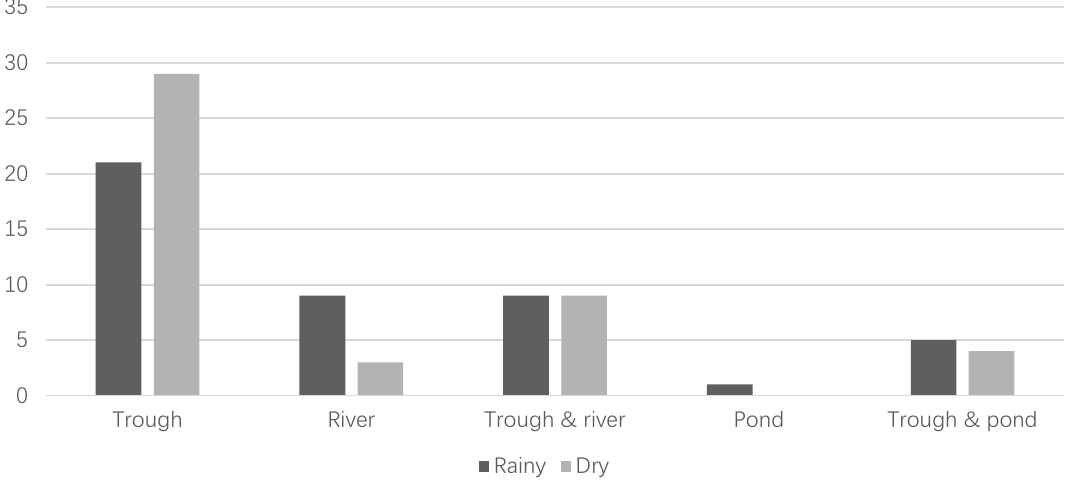
Figure 1. Assessment of sources of drinking water for the animals in this study ( n = 45) during the two seasons. Three different sources of water were observed: troughs, rivers and ponds, as well as two different combinations i.e., trough and river and trough and pond.